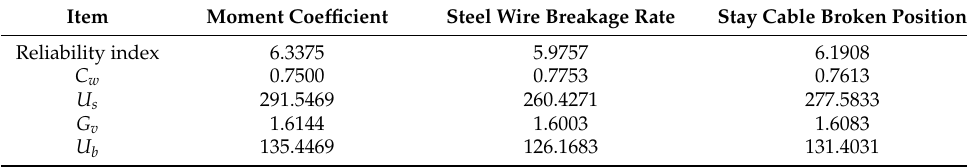
Table 8. Calculation results of static wind